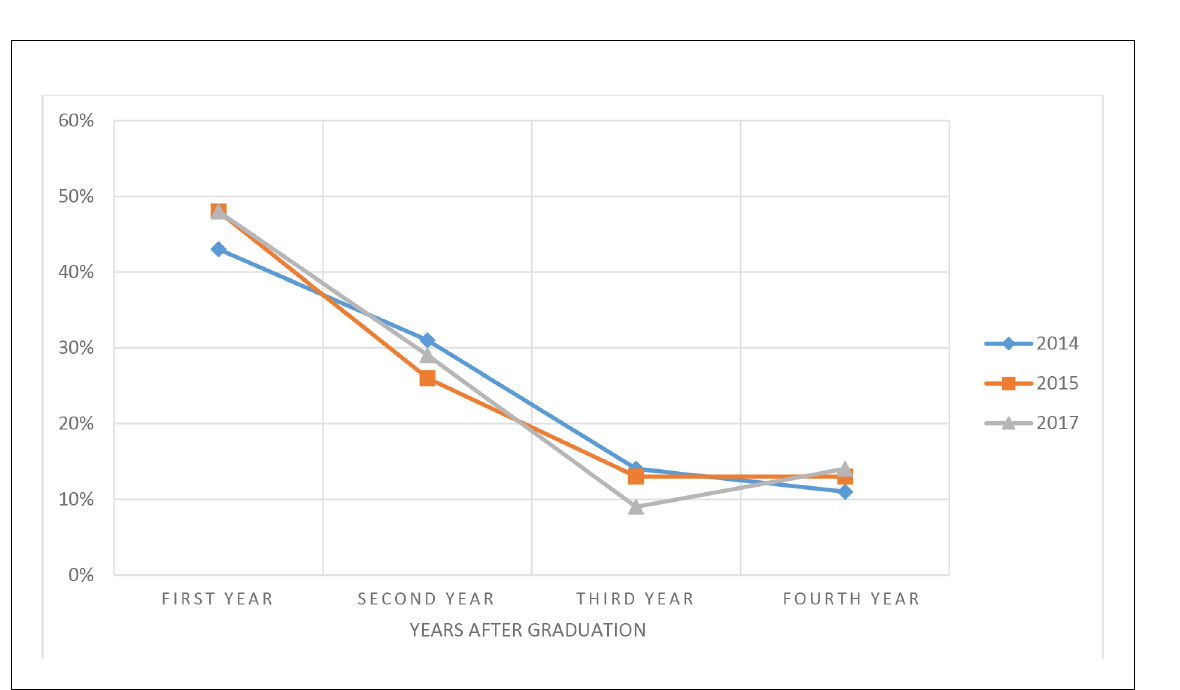
Figure 2. Year of emigration after graduation among GP graduates who had already emigrated at the time of the survey.